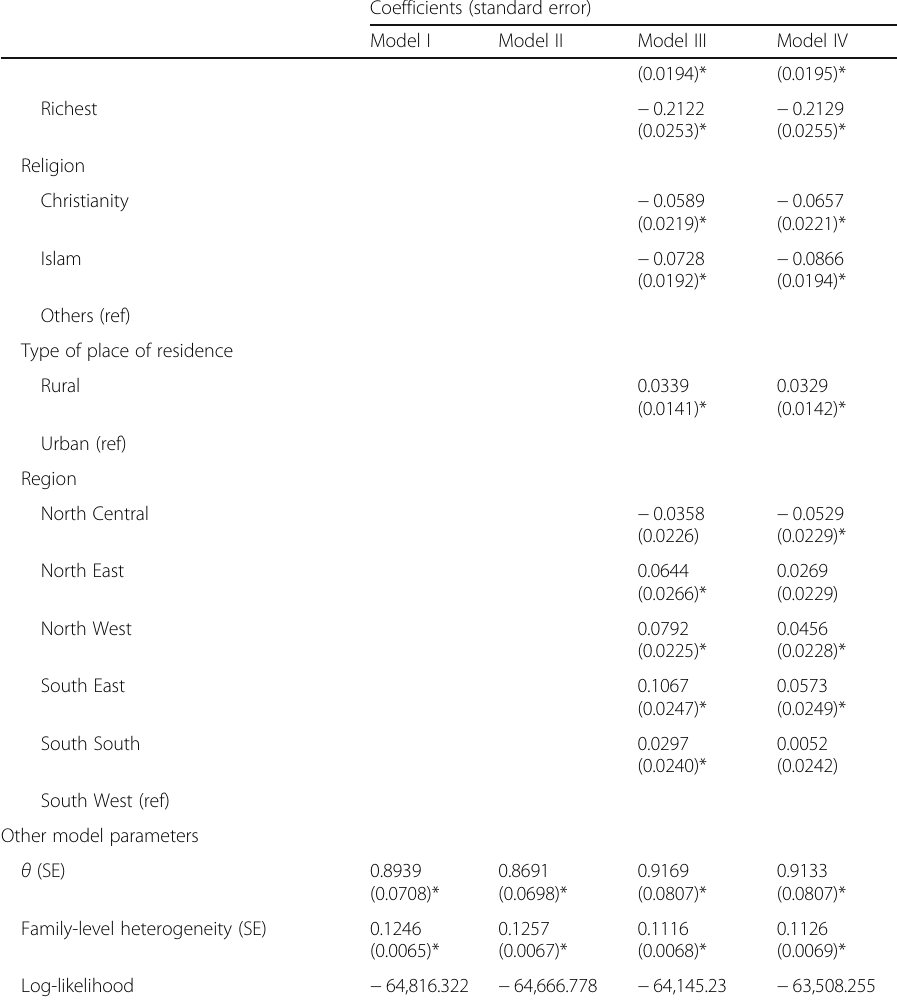
Table 5 Results from dynamic random effects models for infant mortality, Nigeria, 1980 – 2013